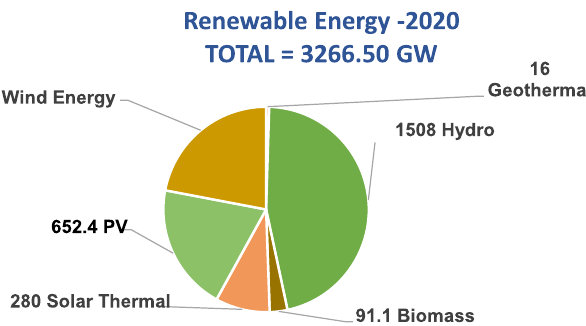
Fig. 28. Global Renewable Energy end of